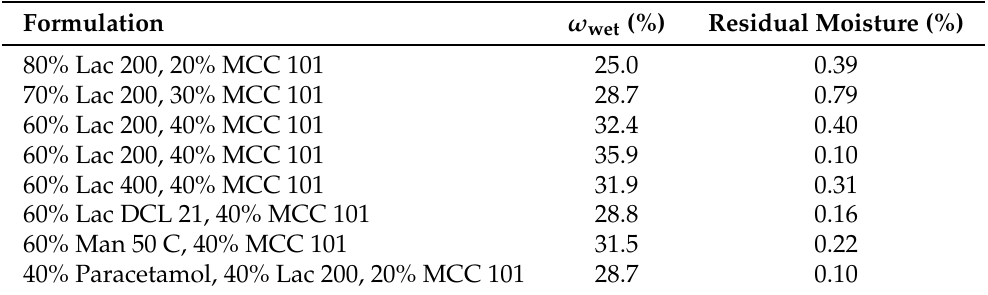
Table A2. Determined residual moisture contents of the dried pellets corresponding to Table 4, Figure 4 and Table 5, Figure